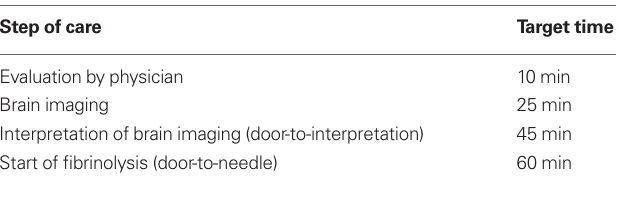
Table 1 | Target times from acute stroke presentation to fibrinolytic treatment.